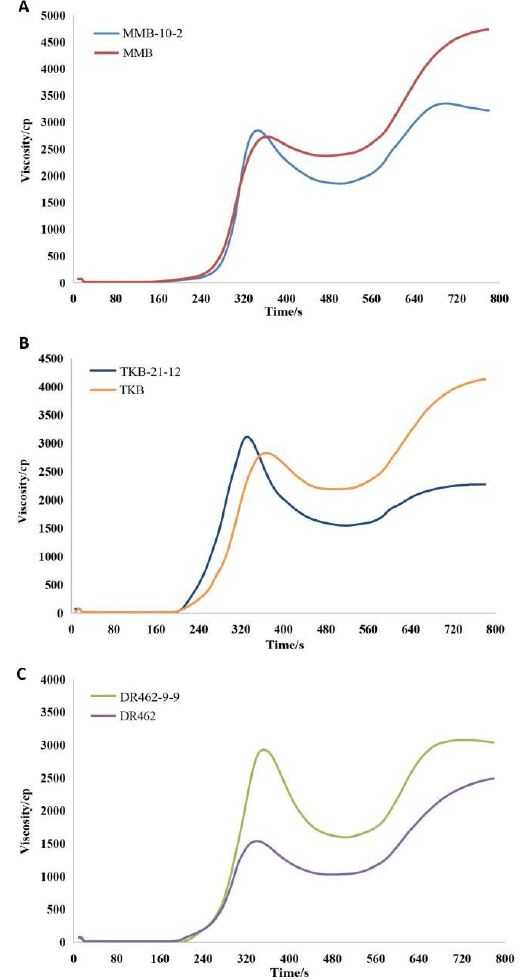
Figure 8. Comparison of RVA profiles between mutant lines in the T 2 generation and their